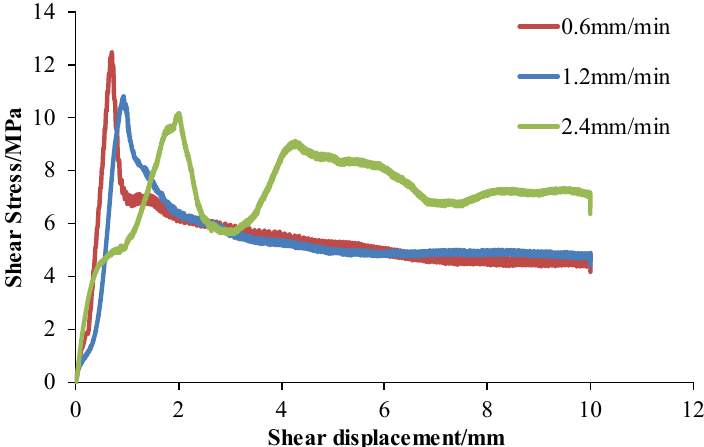
Figure 13. Shear stress–displacement curves under different shear rates at 4 MPa normal stress with a 40° undulating angle.